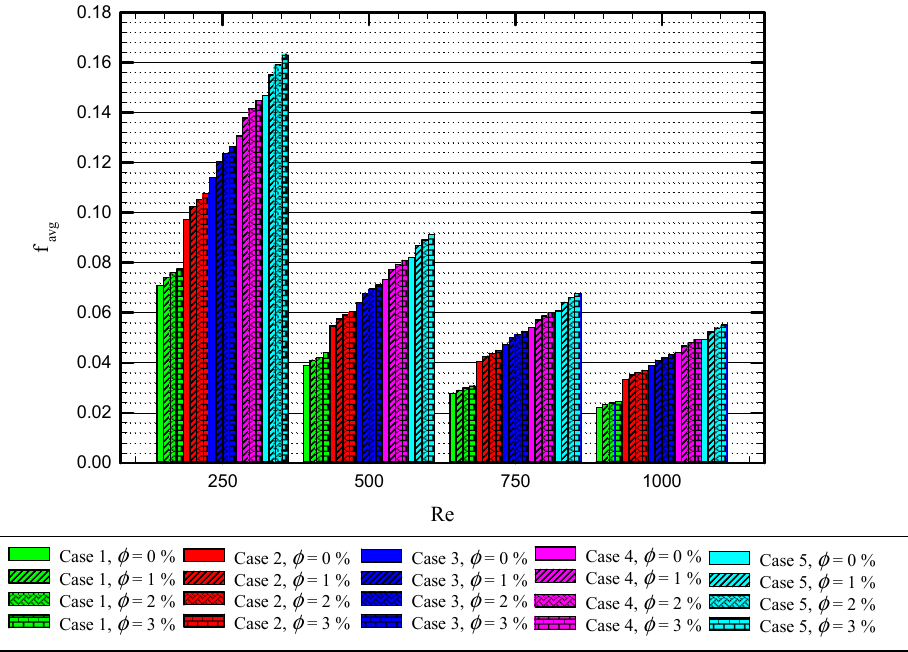
Figure 19. The relation between the average friction and Re at different nanoparticles concentration for Cases 1, 2, 3, 4, and 5.